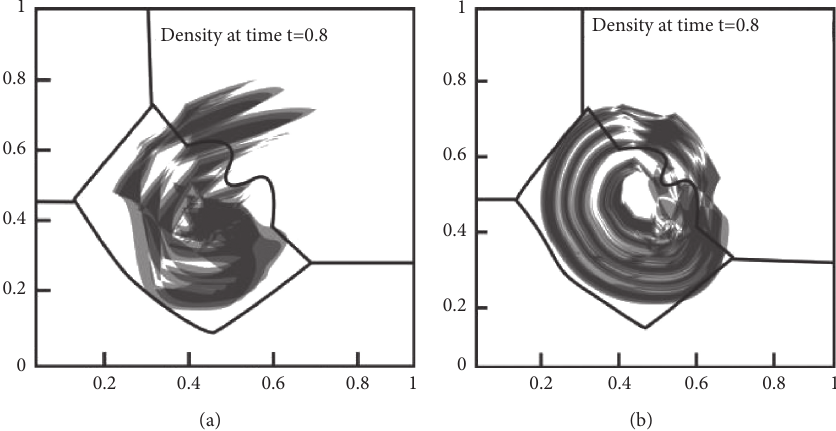
Figure 5: Two-dimensional Riemann problem. (a) Use WEN05 to solve the density contours of GRP format (24) of the conservative equations. (b) The traditional algorithm solves the contour value with density of